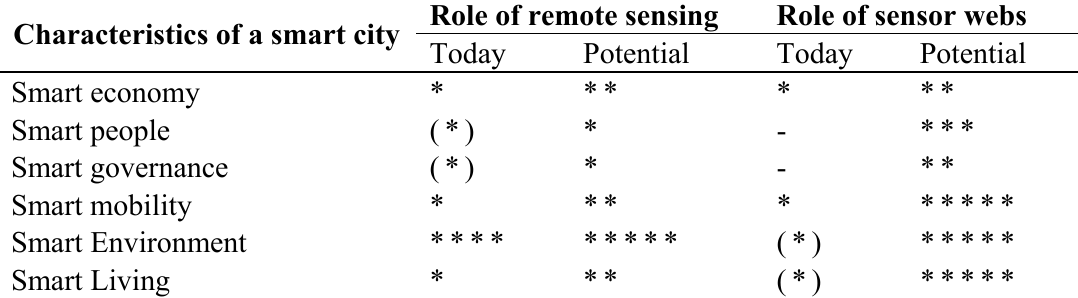
Table 2.: Six characteristics of a smart city based on Giffinger et al. [134], and an evaluation of remote sensing and Sensor Webs in terms of their recent and potential roles within the next five to ten years. Five stars is the maximum, which means a full exploitation of the respective technology and a vital role for the respective